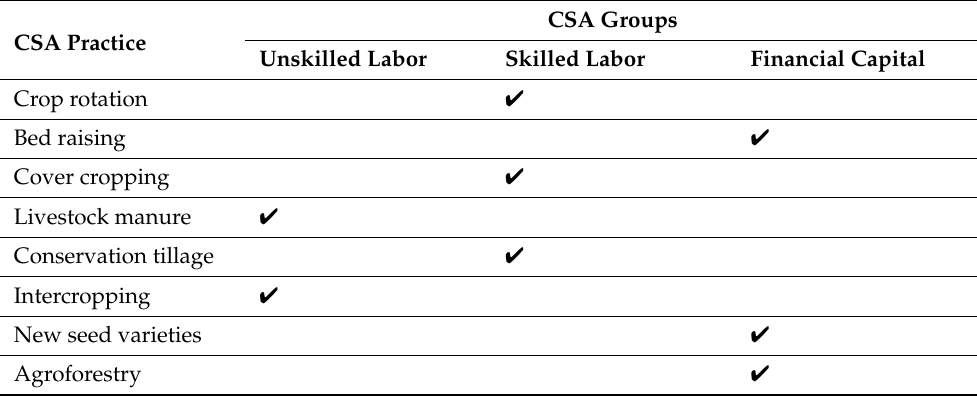
Table 1. Categorization of CSA